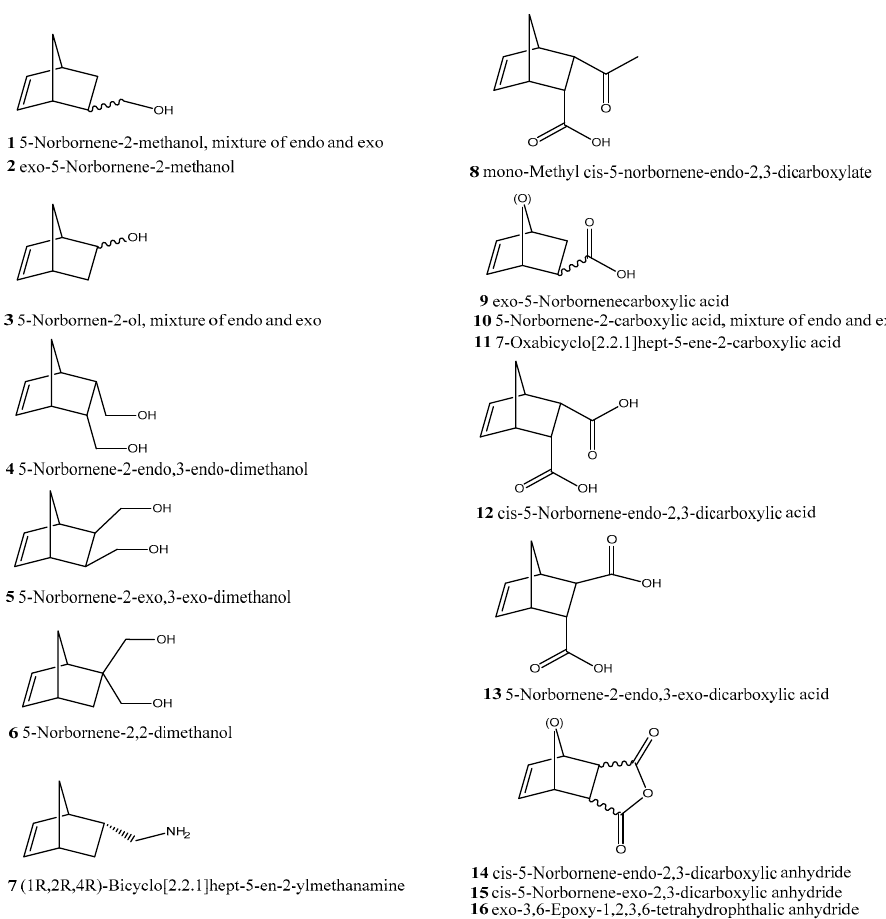
Figure 8. Structures of molecular brushes with ( a ) (oxa)norbornene- and ( b ) 1,4-butadiene- main chains.